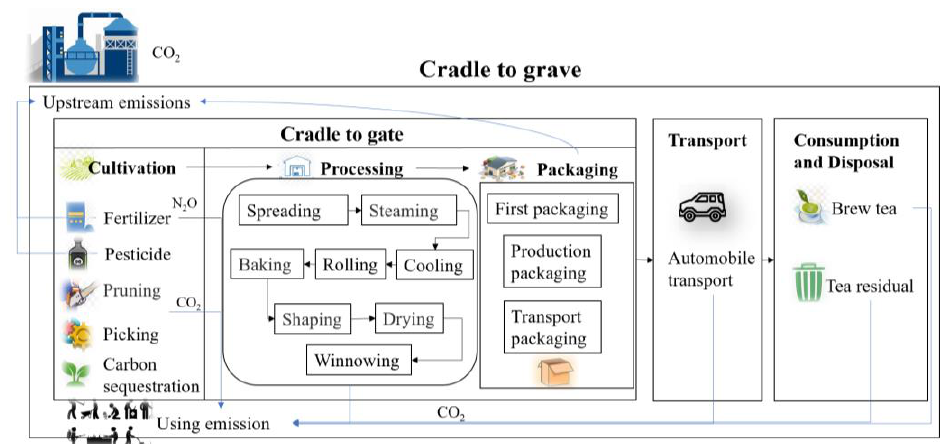
Figure 2. LCA system